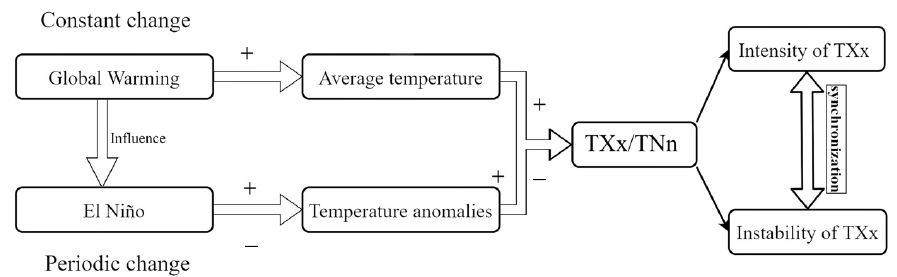
Figure 16. Processes affecting TXx instability.